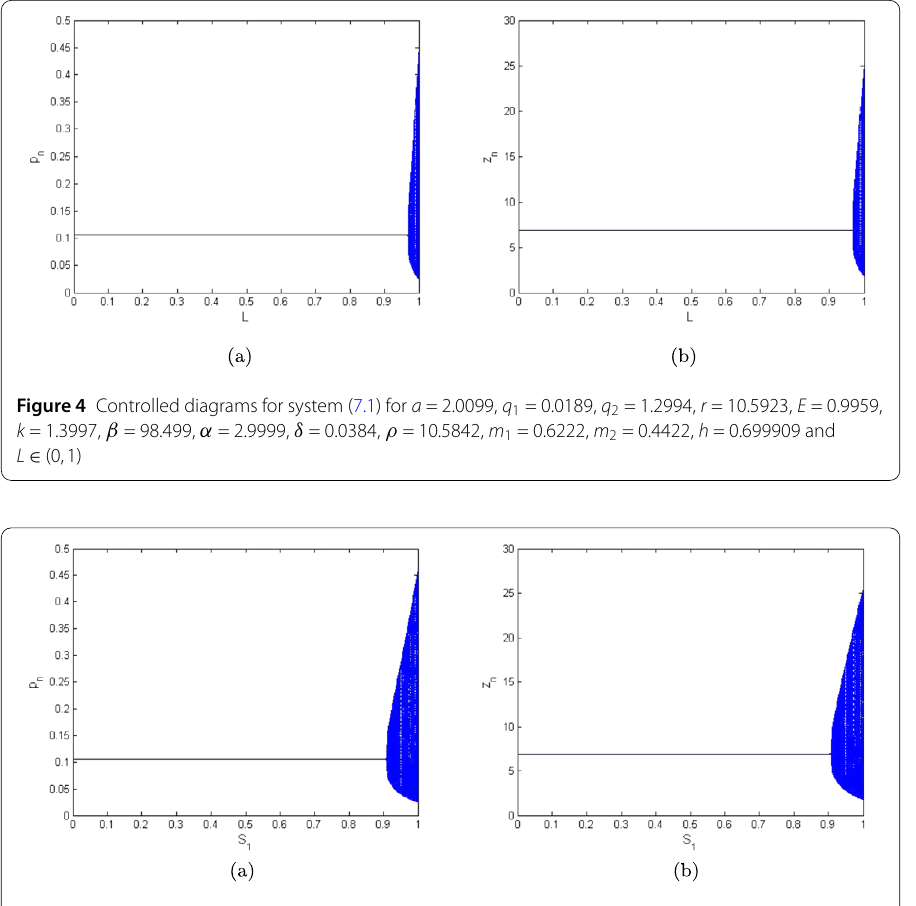
Figure 5 Controlled diagrams for system (7.4) for a = 2.0099, q 1 = 0.0189, q 2 = 1.2994, r = 10.5923, E = 0.9959, k = 1.3997, β = 98.499, α = 2.9999, δ = 0.0384, ρ = 10.5842, m 1 = 0.6222, m 2 = 0.4422, h = 0.699909, and S 1 ∈ (0,1)